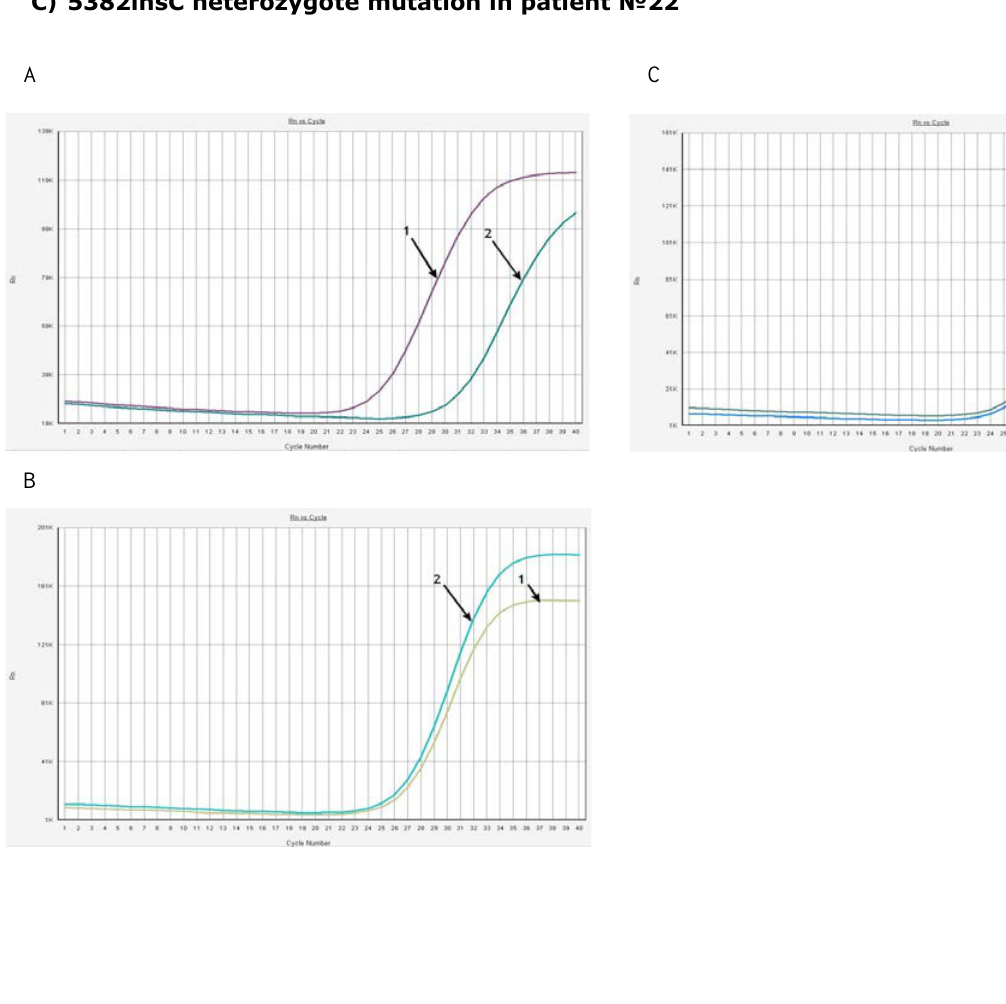
Figure.1 Allele-specific PCR detection of BRCA1 5382insC